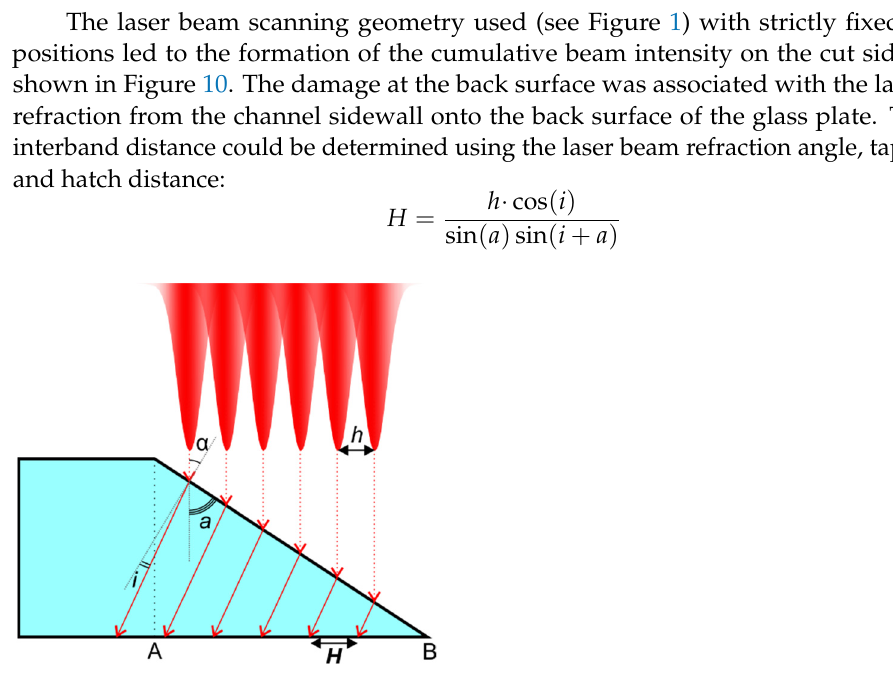
Table 4. The distance (period) between the individual band-like damages formed during glass cut- ting in ambient air.